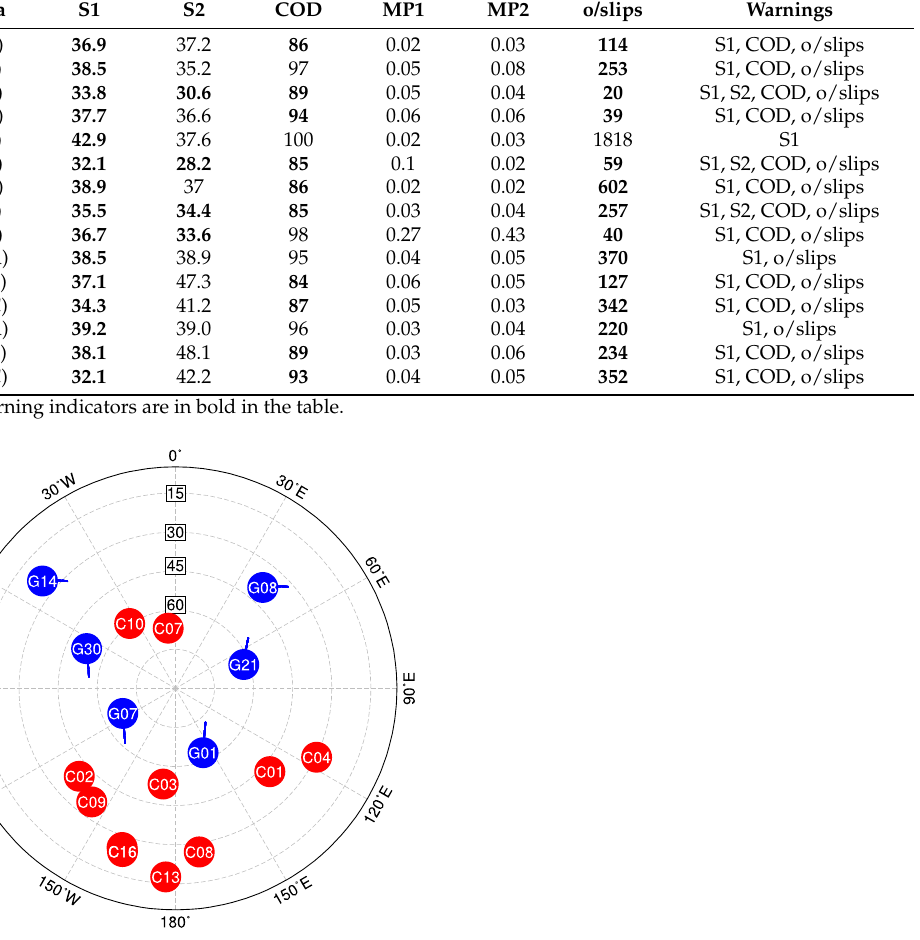
Figure 10. Skyplot of site A.